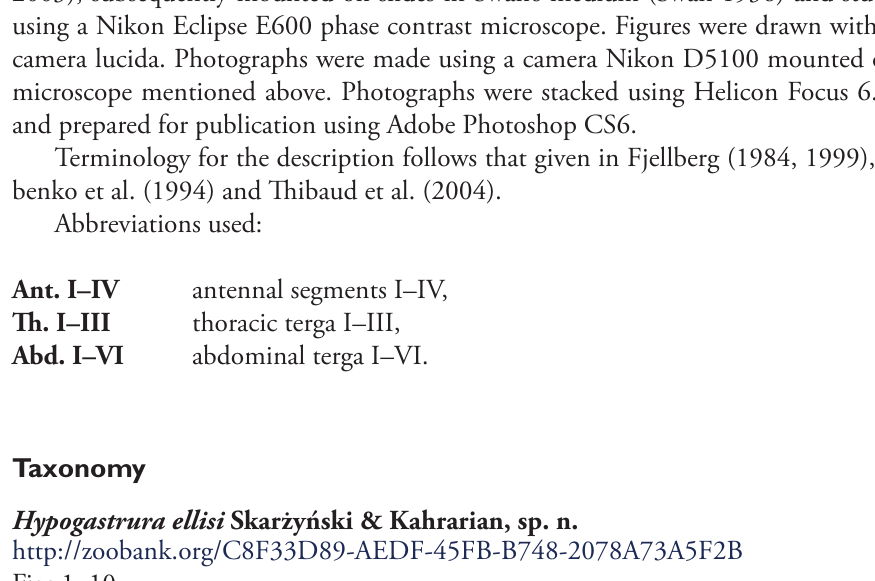
Type material. Holotype: female on slide, litter in oak forest, Zagros Mountains, Dalab mountain (33°34'N, 47°31'E / 1700 m a.s.l.), Kohdasht County, Lorestan Province, Iran, 4.XII.2013, leg. M. Kahrarian. Paratypes: 4 females, 1 male, same data as holotype; 1 female, 1 male, litter in oak forest, Zagros Mountains, Sorkhdom mountain (33°34'N, 47°32'E / 1650 m a.s.l.), Kohdasht County, Lorestan Province, Iran, 14.XI.2013, leg. M. Kahrarian; 2 females, 1 male, litter in oak forest, Zagros Mountains, near Patogh ghaut (34°25'N, 46°00'E / 1030 m a.s.l.), Sarpol-e-zahab County, Kermanshah Province, Iran, 9.II.2014, leg. M. Kahrarian; 1 male, oak